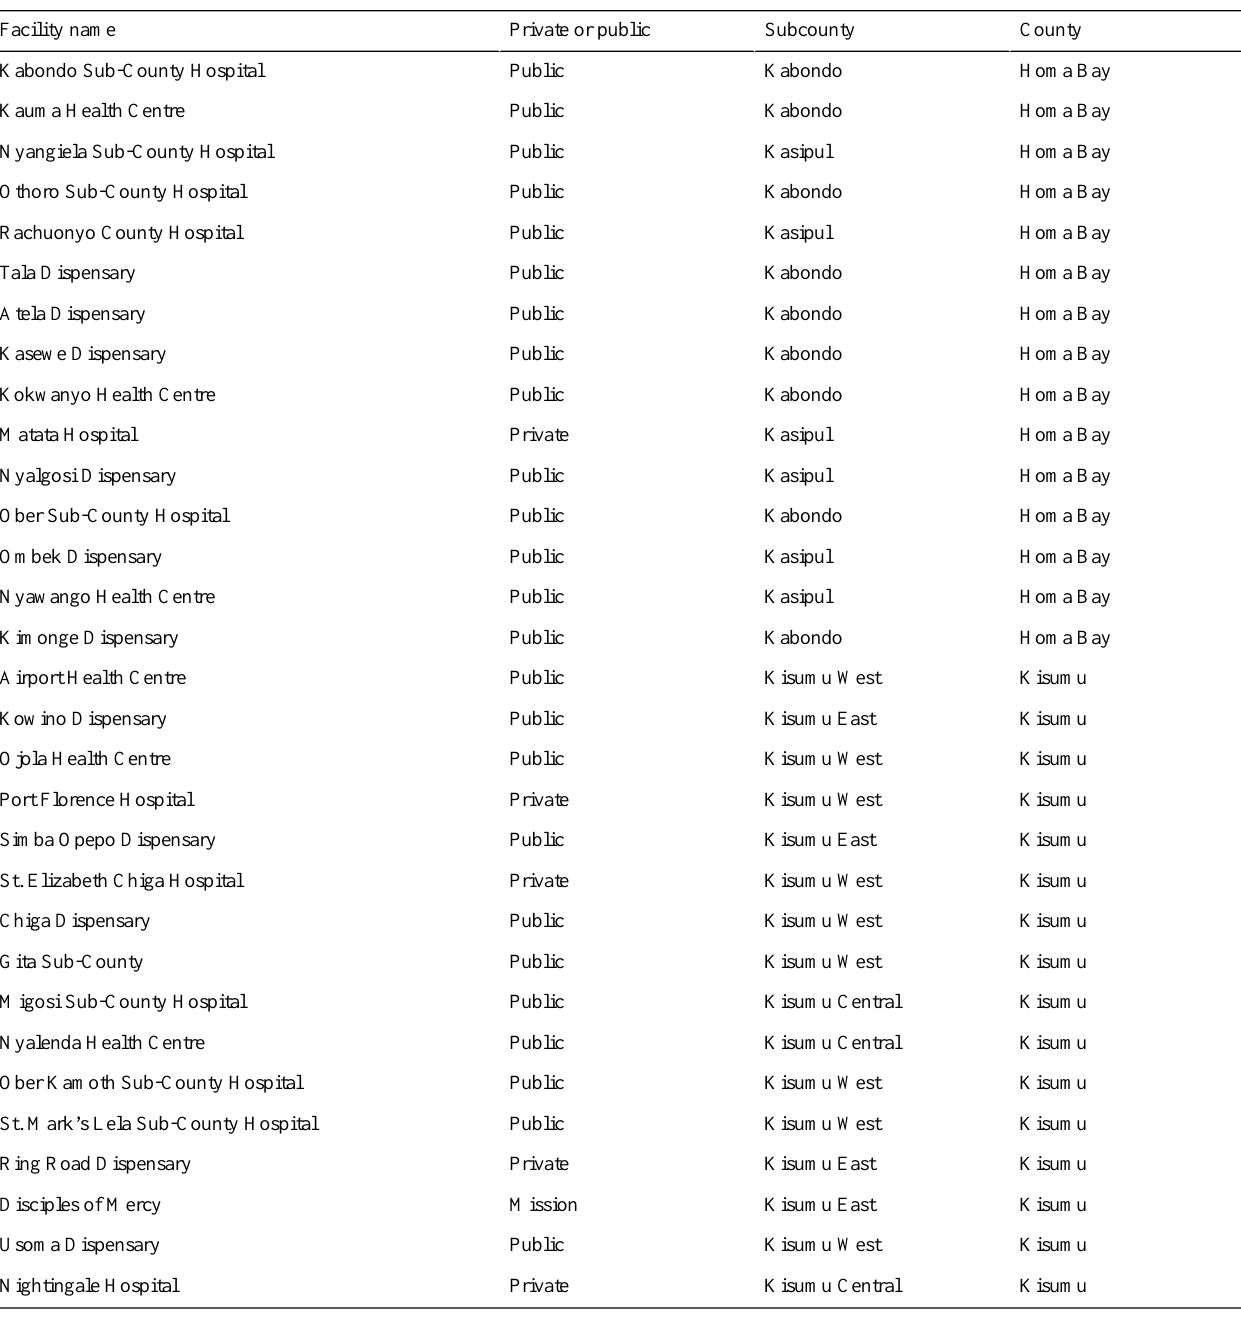
Table 1. Distribution of 31 study sites in Western